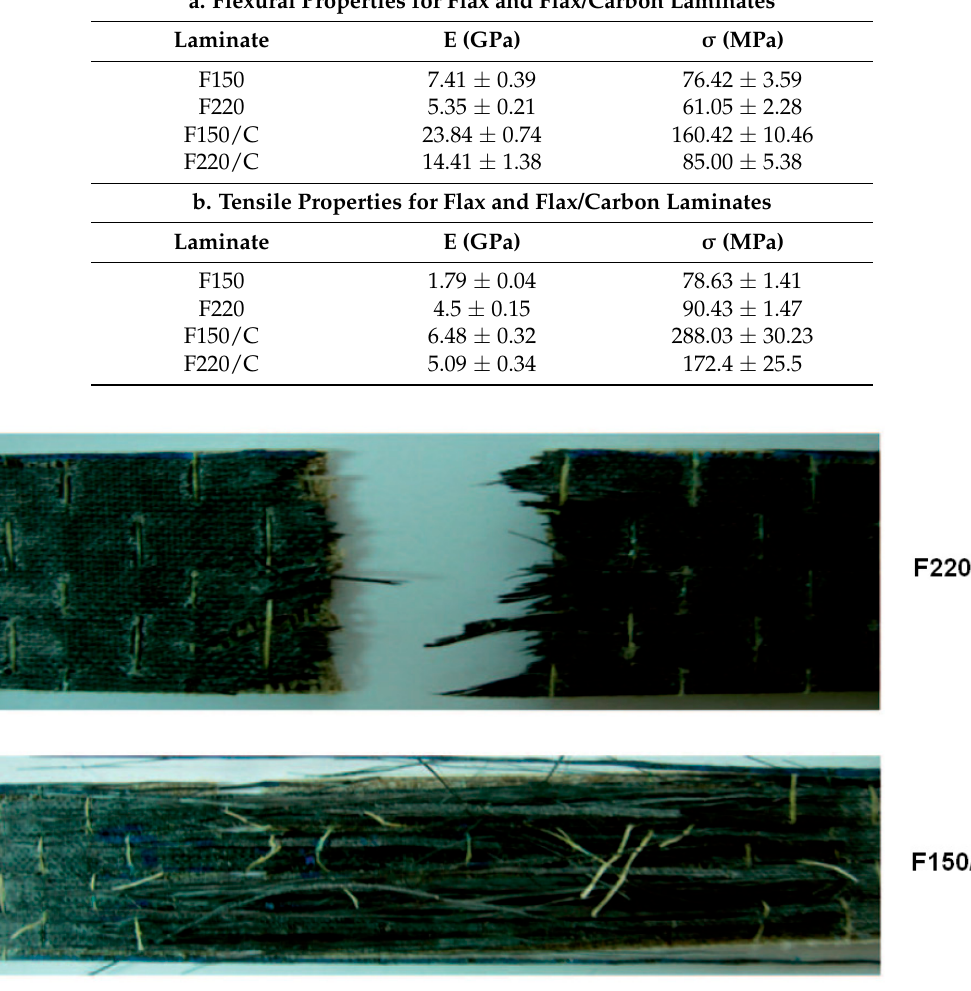
Table 5. The configurations for the carbon–basalt fiber hybrid composites study [36]. (Reproduction permission obtained).